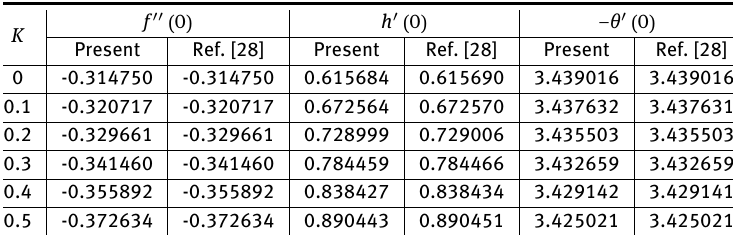
Table 1: Comparison of results for validation as β * = 100000.